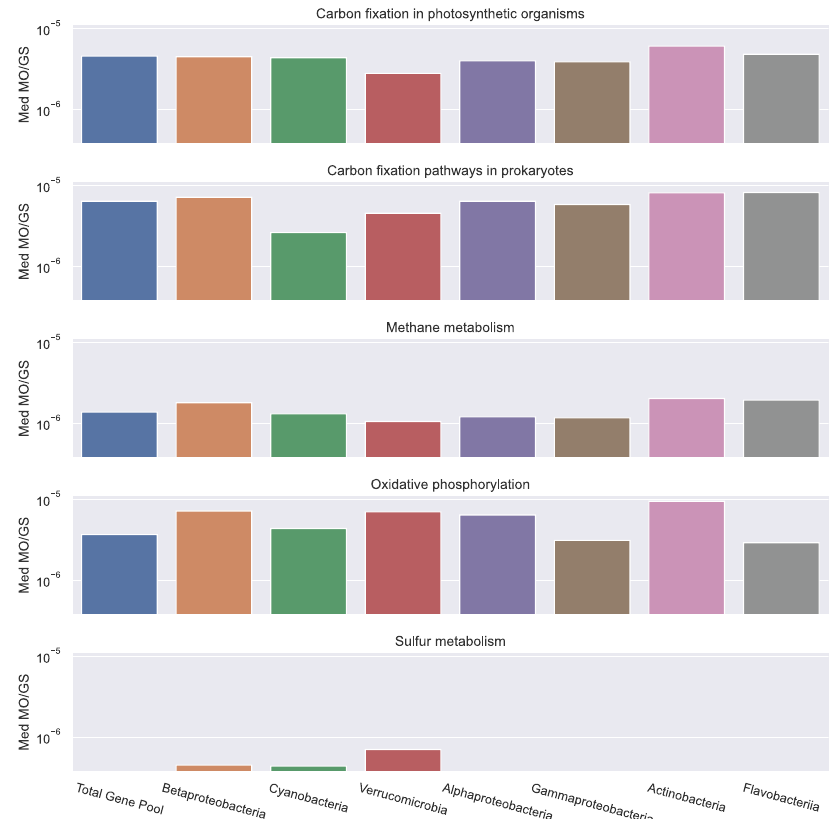
Fig. 8 Median metabolic overlap of the KEGG energy metabolisms modules calculated for the total community and the dominant classes. KEGG energy metabolism modules with a median metabolic overlap of 0 in the total gene pool and the classes examined are not